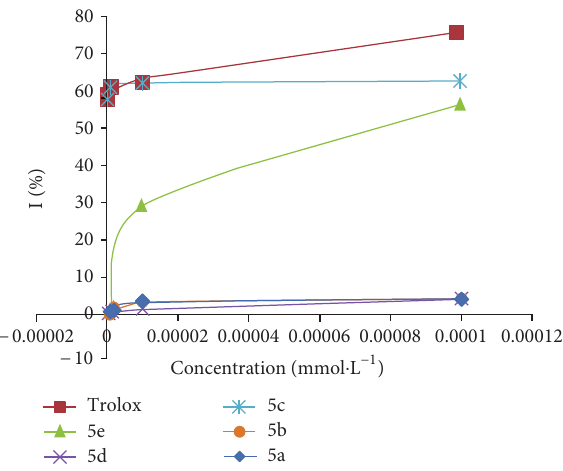
S 4: Scavenging effect on 1,1-diphenyl-2-picrylhydrazyl (DPPH) radical of compounds 5 .